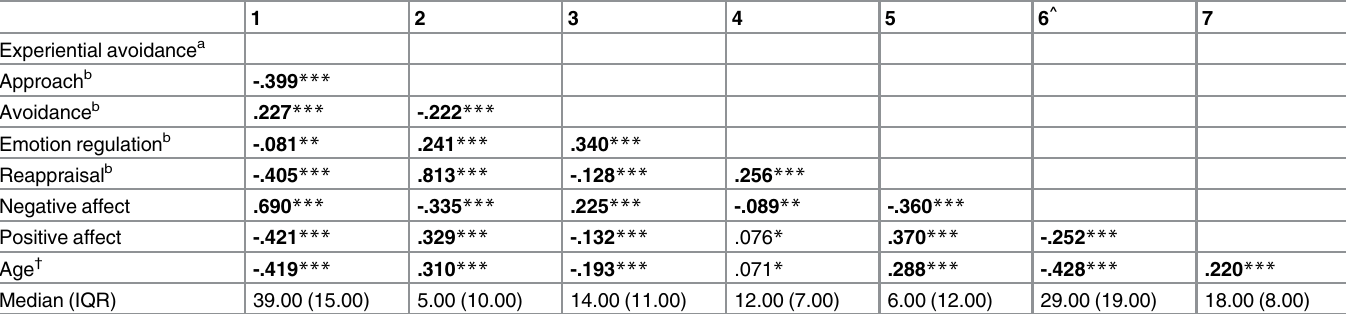
Table 3. Spearman Rho correlation analyses investigating the associations between experiential avoidance, coping function, age and affect ( N =